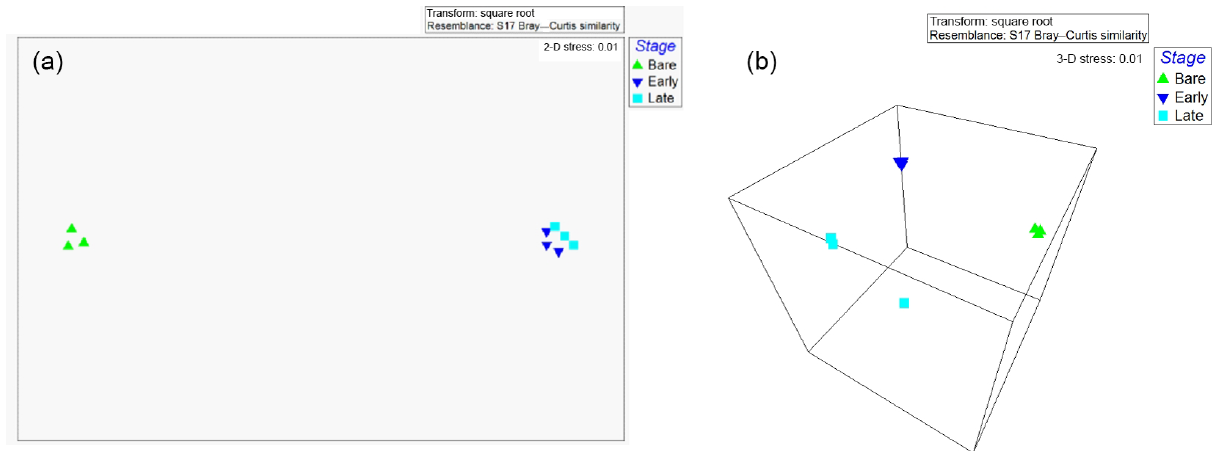
Figure 7. Non-metric multidimensional scaling of bare soil and early- and late-stage biocrusts within two dimensions (a) and three dimen- sions (b) .